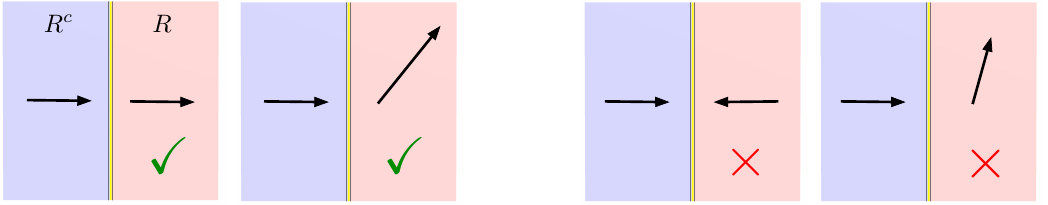
Figure 20 . Candidate classical initial electromagnetic field configurations (phase space points), with A = 0 , A = 0 , showing electric field E 0 i the boundary, disqualifying the two candidates on the